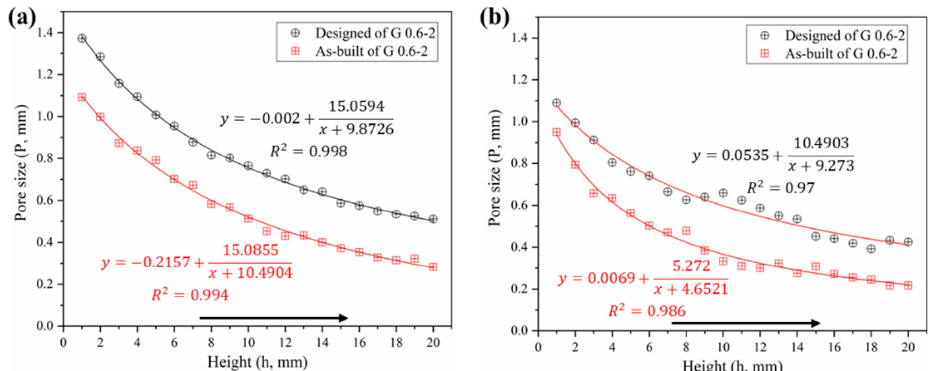
Figure 8. Comparative analysis of pore size distribution between designed and as-built models, ( a ) Gyroid gradient porous structure, ( b ) Diamond gradient porous structure.